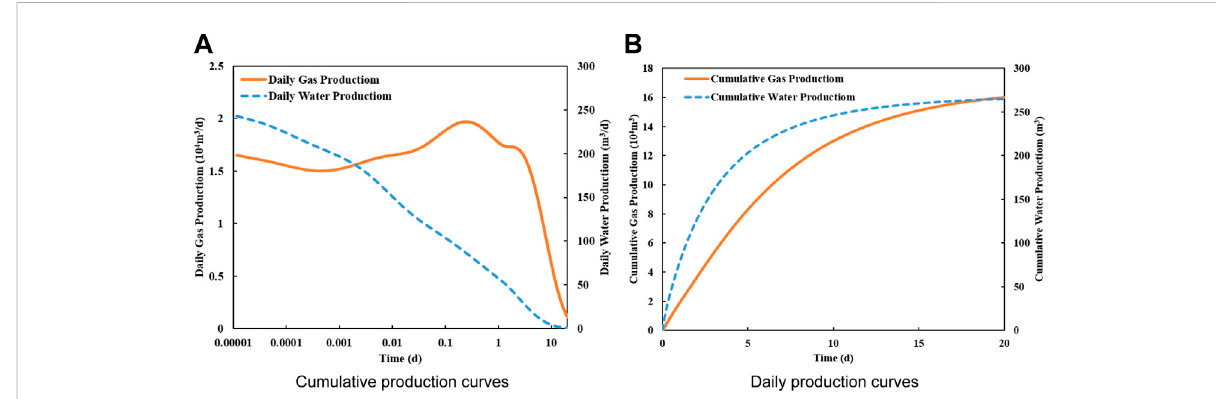
FIGURE 13 Curves of daily production and cumulative production of shale gas well. (A) is daily production curves. (B) is cumulative production curves.